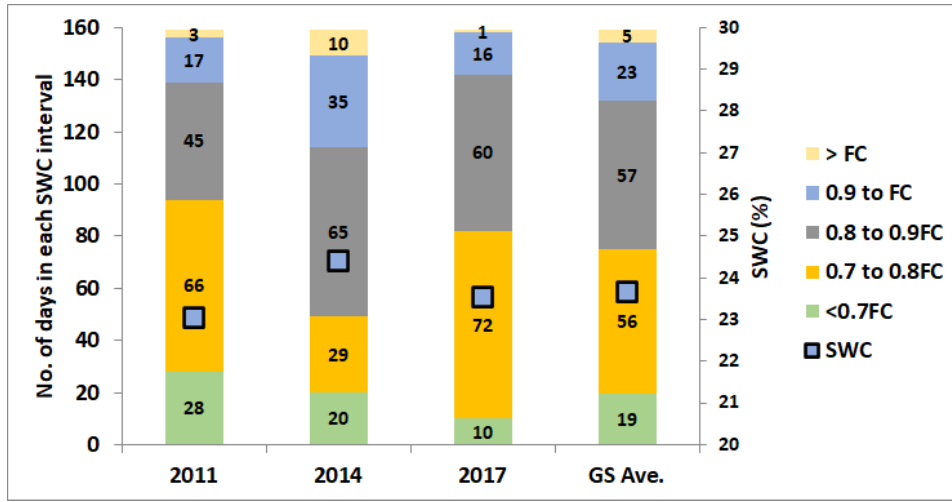
Figure 5. Number of days with soil water content (SWC) in each SWC interval for each potato growing season.